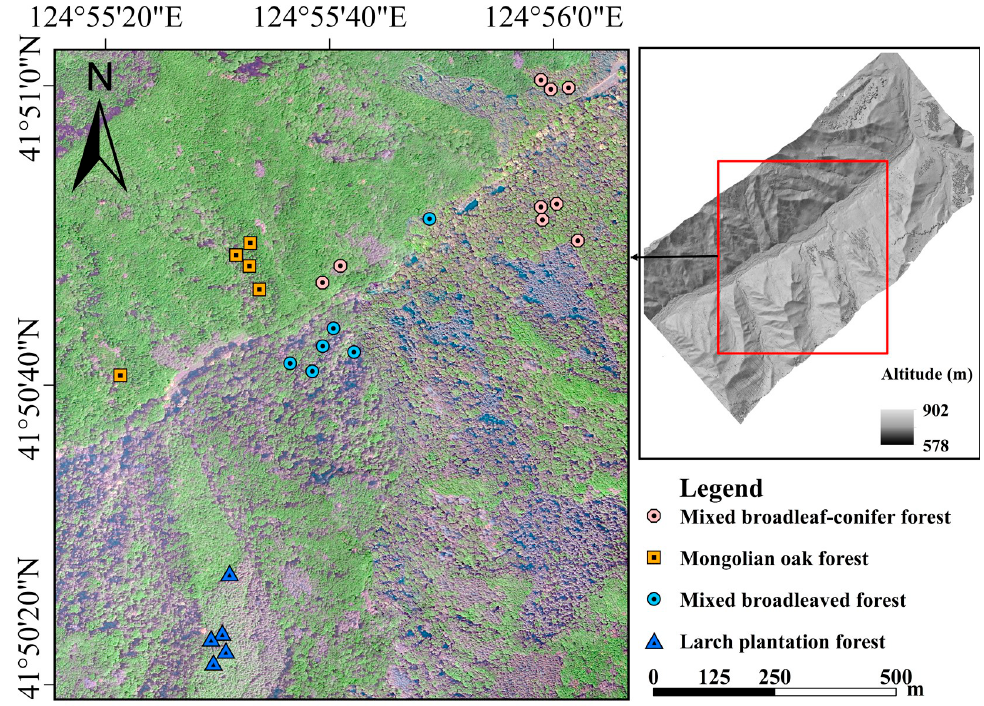
Figure 1. The study area and distribution of plots. Table 1. General description of the study